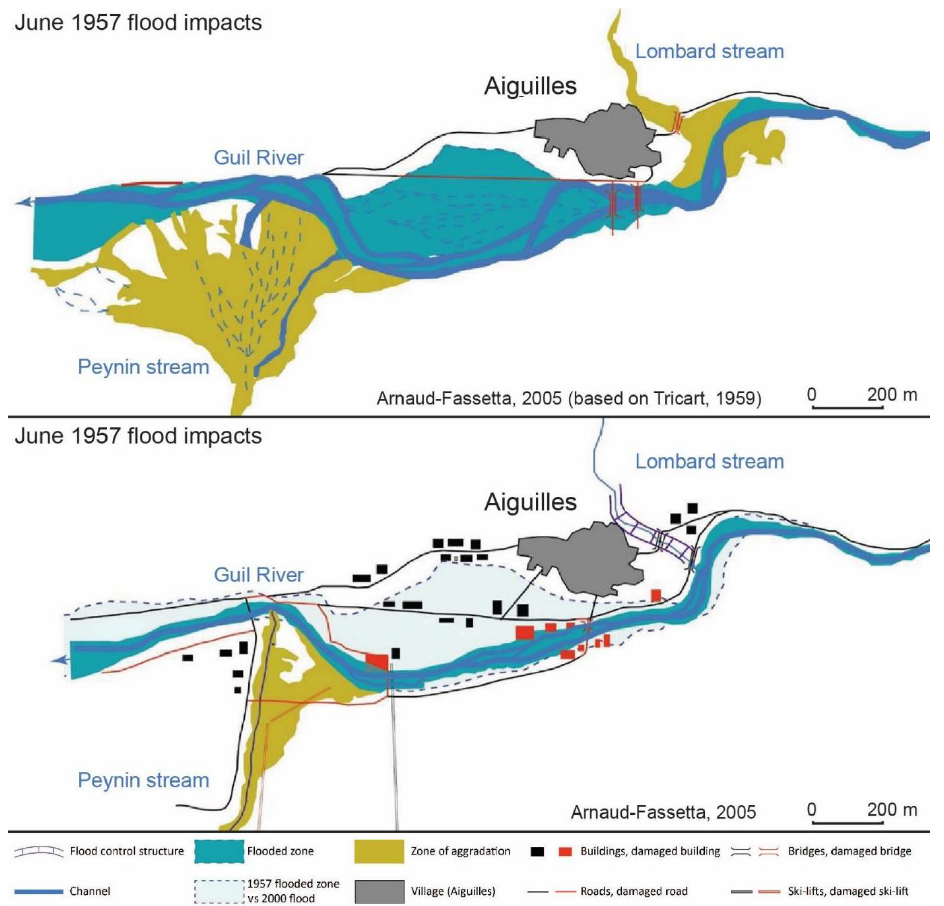
Figure 2. Impacts of the June 1957 and June 2000 floods on the village of